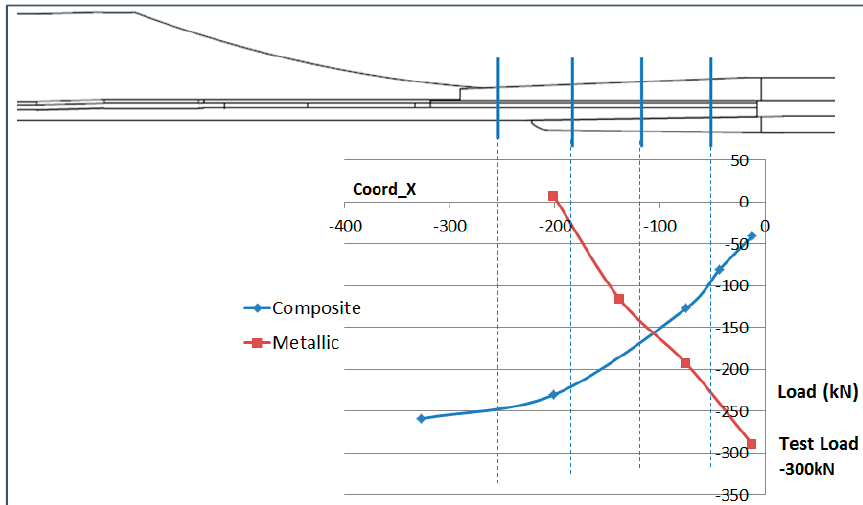
Figure 27. Load Split in Compression ( − 300 kN).